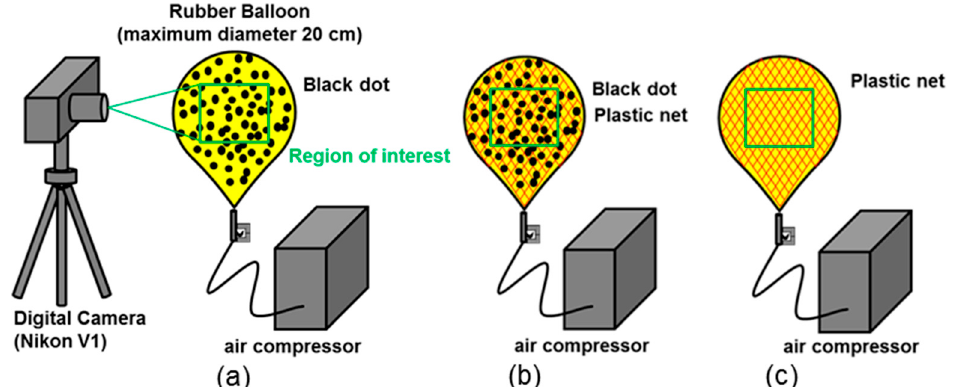
Figure 3. Experimental setups for the displacement measurement. ( a ) Random spray pattern; ( b ) Net + spray pattern; ( c ) Plastic net.